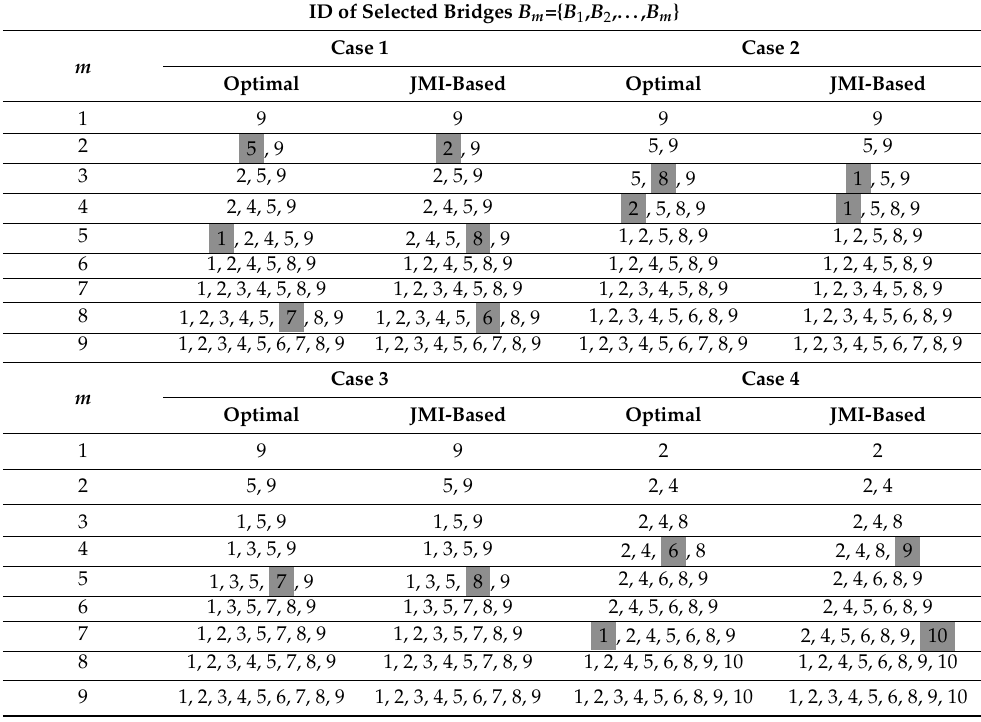
Table 5. Optimal and JMI-based seismic retrofit